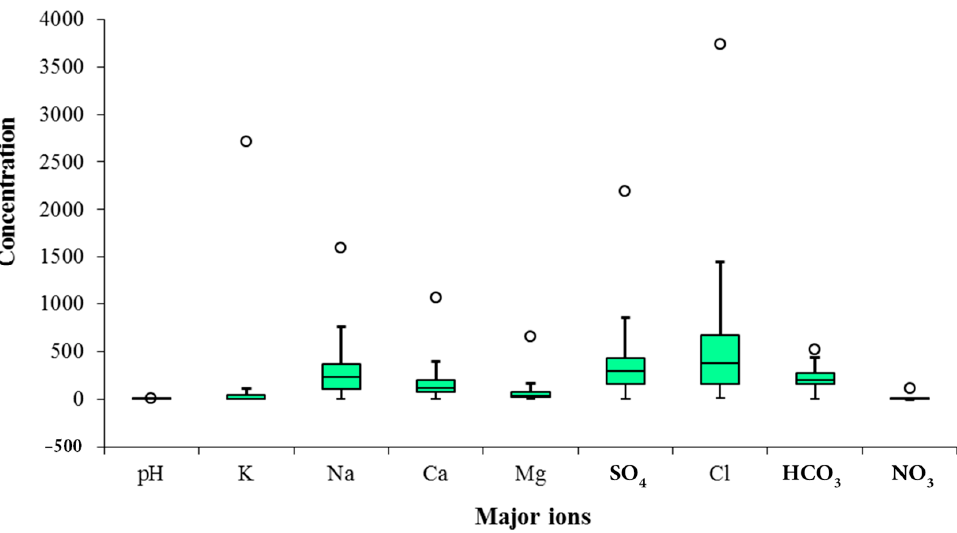
Figure 2. Box plot showing a comparison of major ion concentration (mg/L) in the groundwater samples of the study.